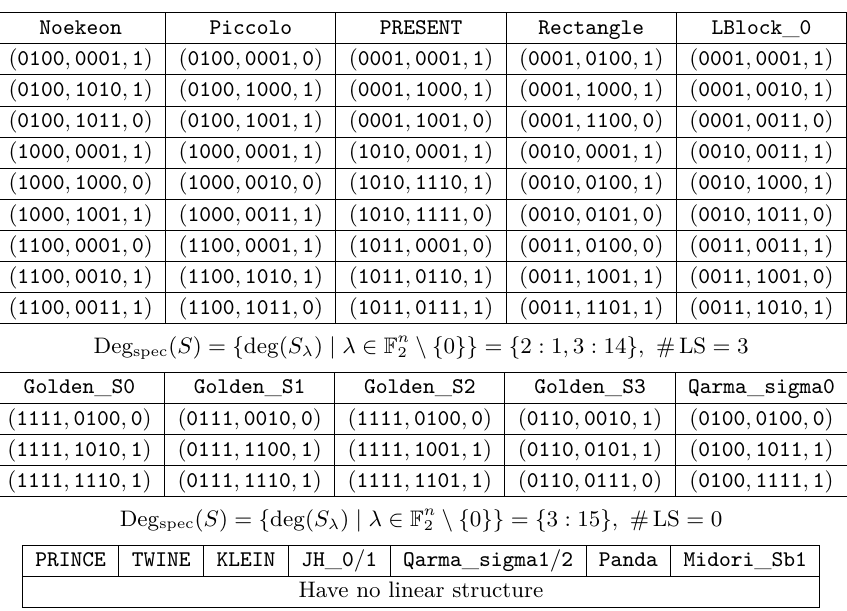
Table 9: Degree spectra and Linear structures of some